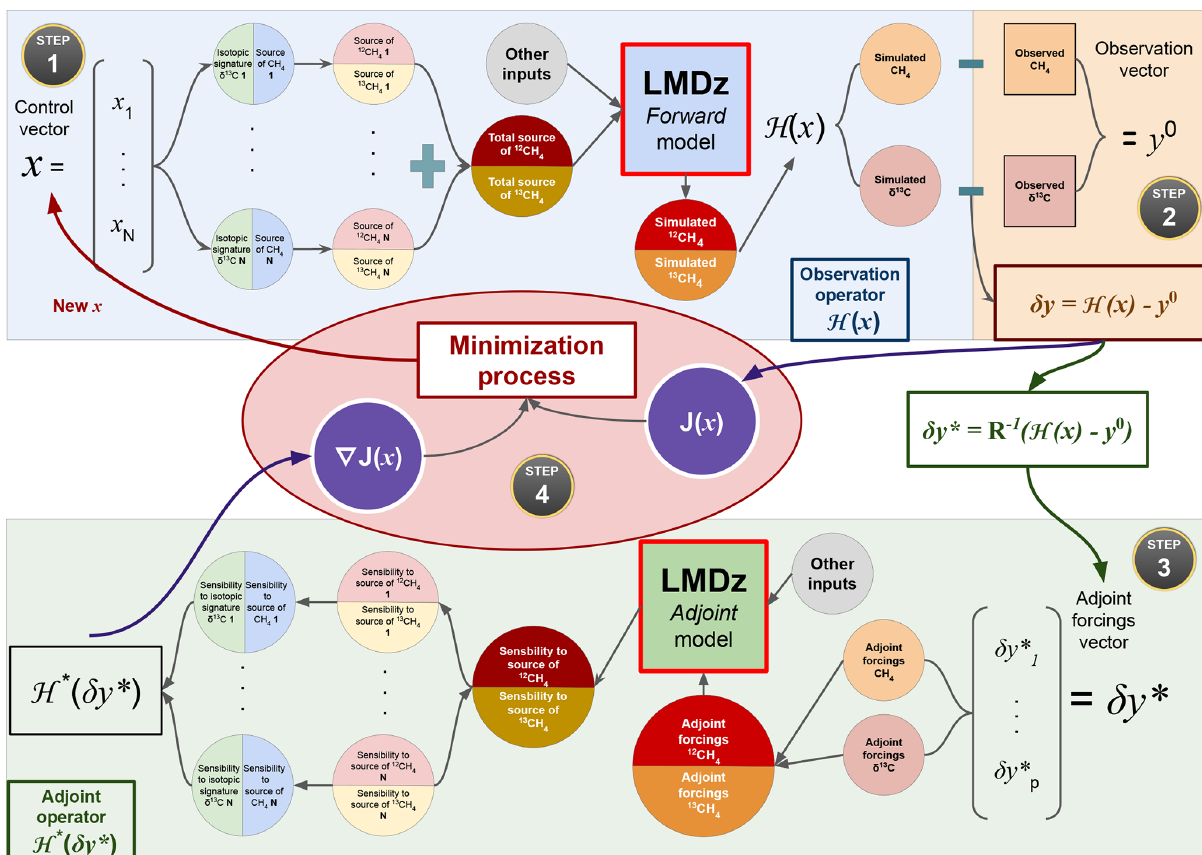
Figure 1. The minimization iteration process in the newly designed system. The black circles with a gold border indicate the reading direction to follow. Step 1 (blue rectangle) refers to a forward run. Step 2 (orange rectangle) refers to the forward and adjoint operations required to compare observations and simulated values. Step 3 (green rectangle) refers to an adjoint run (this step must be read from the right to the left). Step 4 (red ellipse) refers to the minimization of the cost function operated by the dedicated minimization algorithm. Note that results of Step 2 are used in both the minimization process (red ellipse) and as inputs for Step 3. The minimization iteration process followed by the previous system is also illustrated in Fig. S1 in the